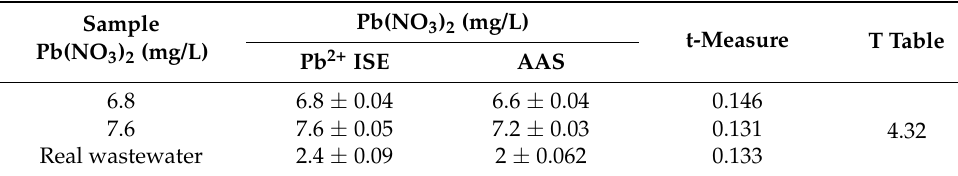
Table 7. Validation of Pb 2+